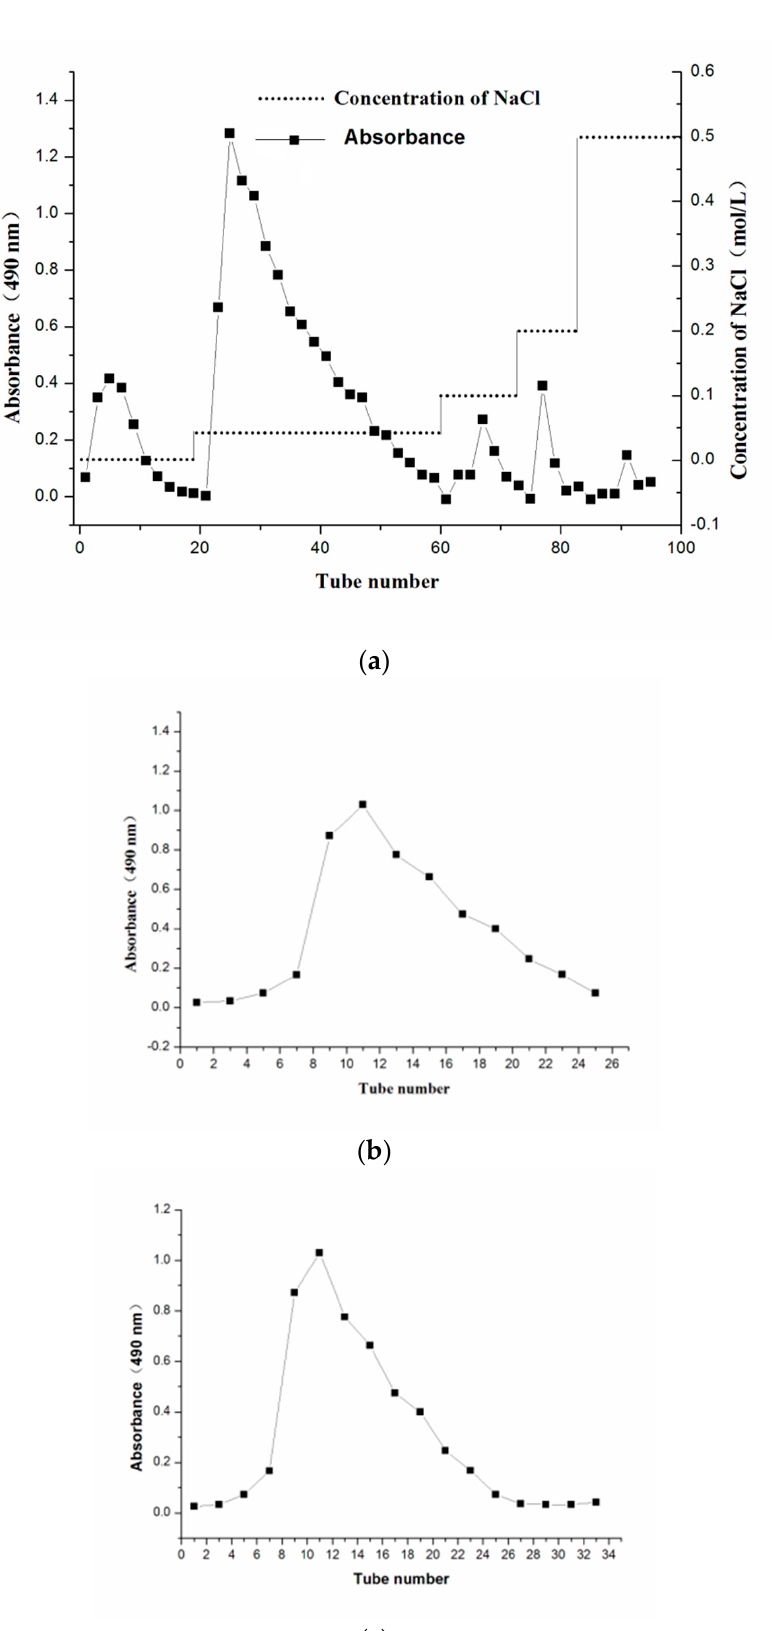
Figure 1. Isolation and purification of crude polysaccharide from F. velutipes. ( a ) The elution curve of F. velutipes polysaccharides (FVP); ( b ) The elution curve of FVP ‐ 1; ( c ) The elution curve of FVP ‐ 2.